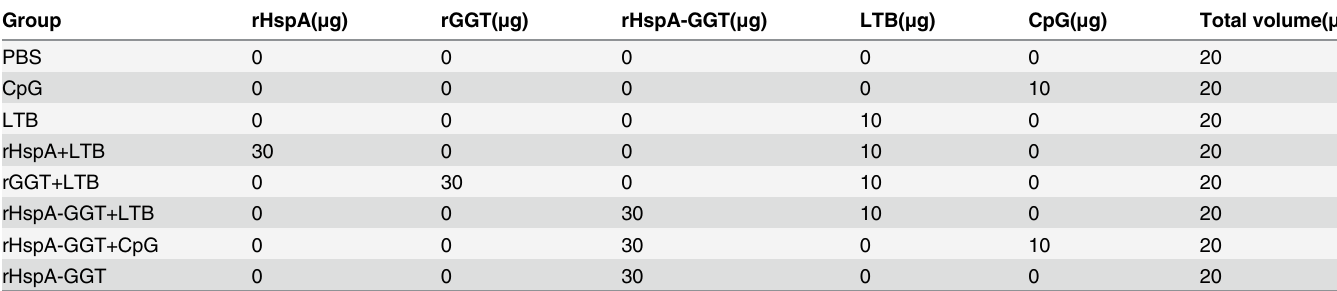
Table 1. Vaccine formulations in each